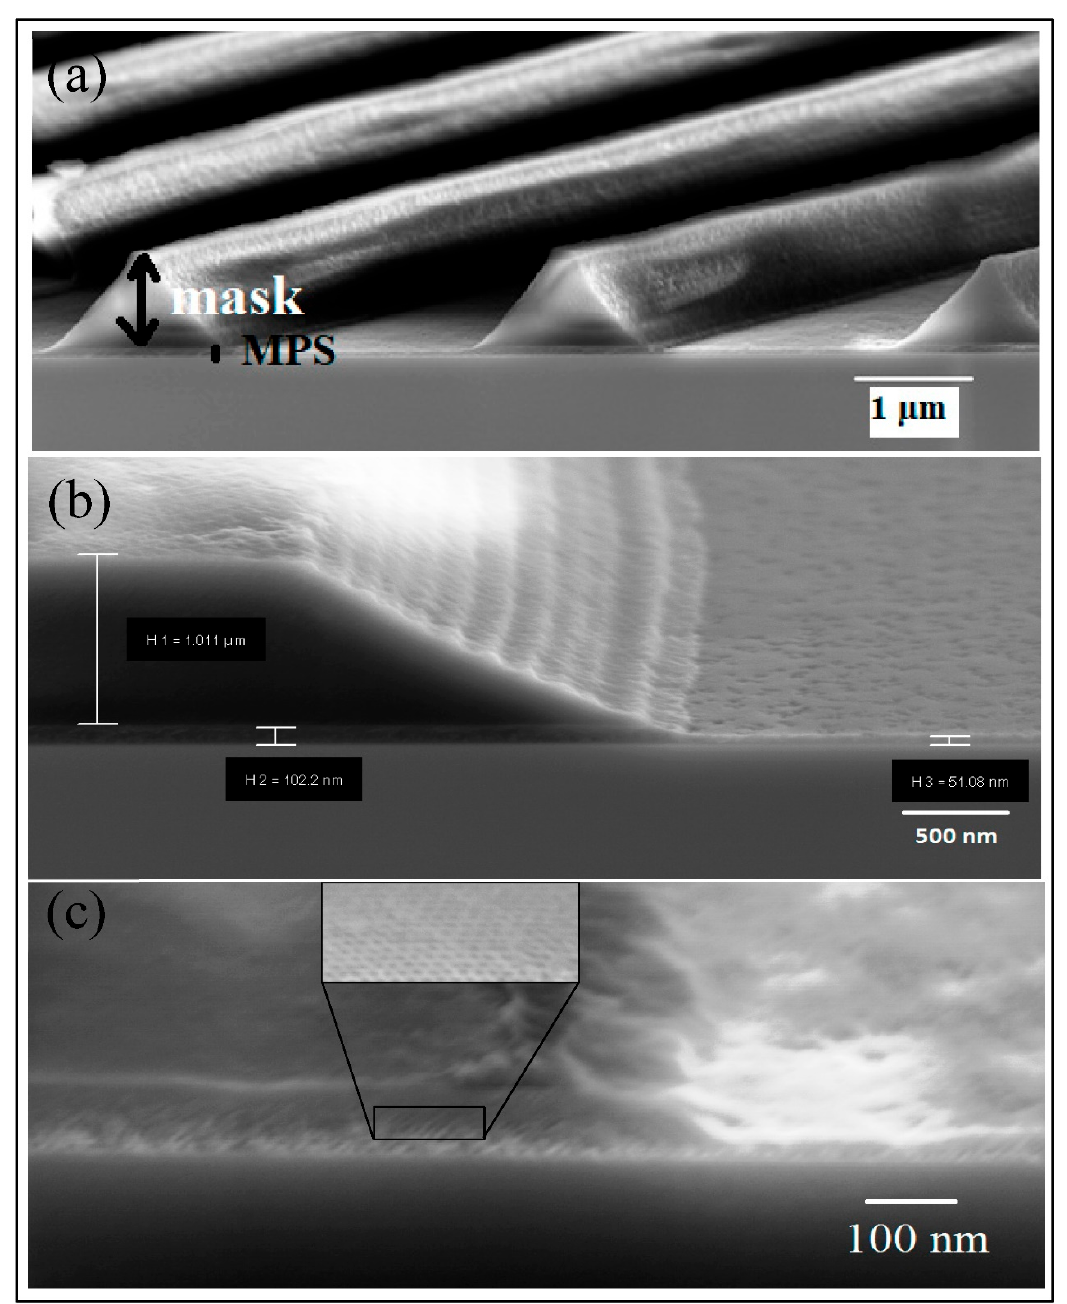
Figure 4. Cross-sectional SEM images of mesoporous silica thins films after ICP dry etching ( a ) etched mesoporous silica thin film with lithographic resist on the top ( b ) magnifying image of the etched mesoporous silica thin film ( c ) etched mesoporous silica thin film after removal of lithographic resist (inset shows the magnifying image).